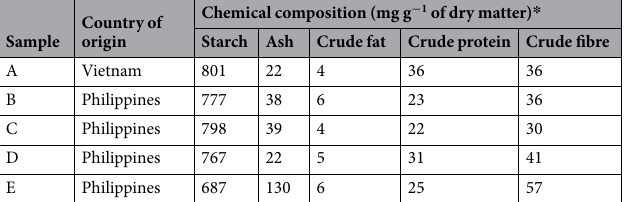
Table 1. Compositional analysis of cassava samples. * Samples analysed by Eurofins Scientific (Belgium).